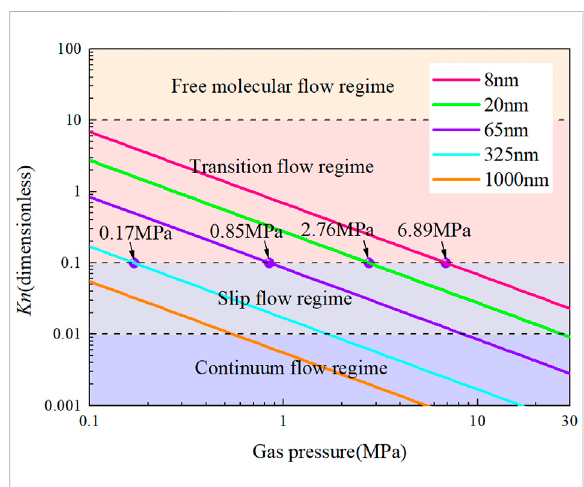
FIGURE 8 Relationship between methane fl ow regimes and pressure in pores with different